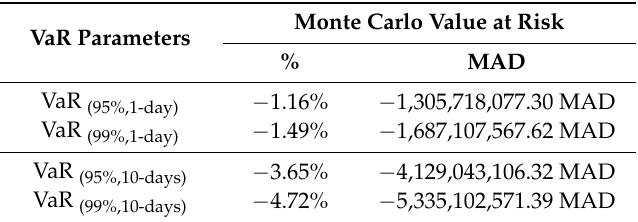
Table produced on Excel under VBA by the authors.